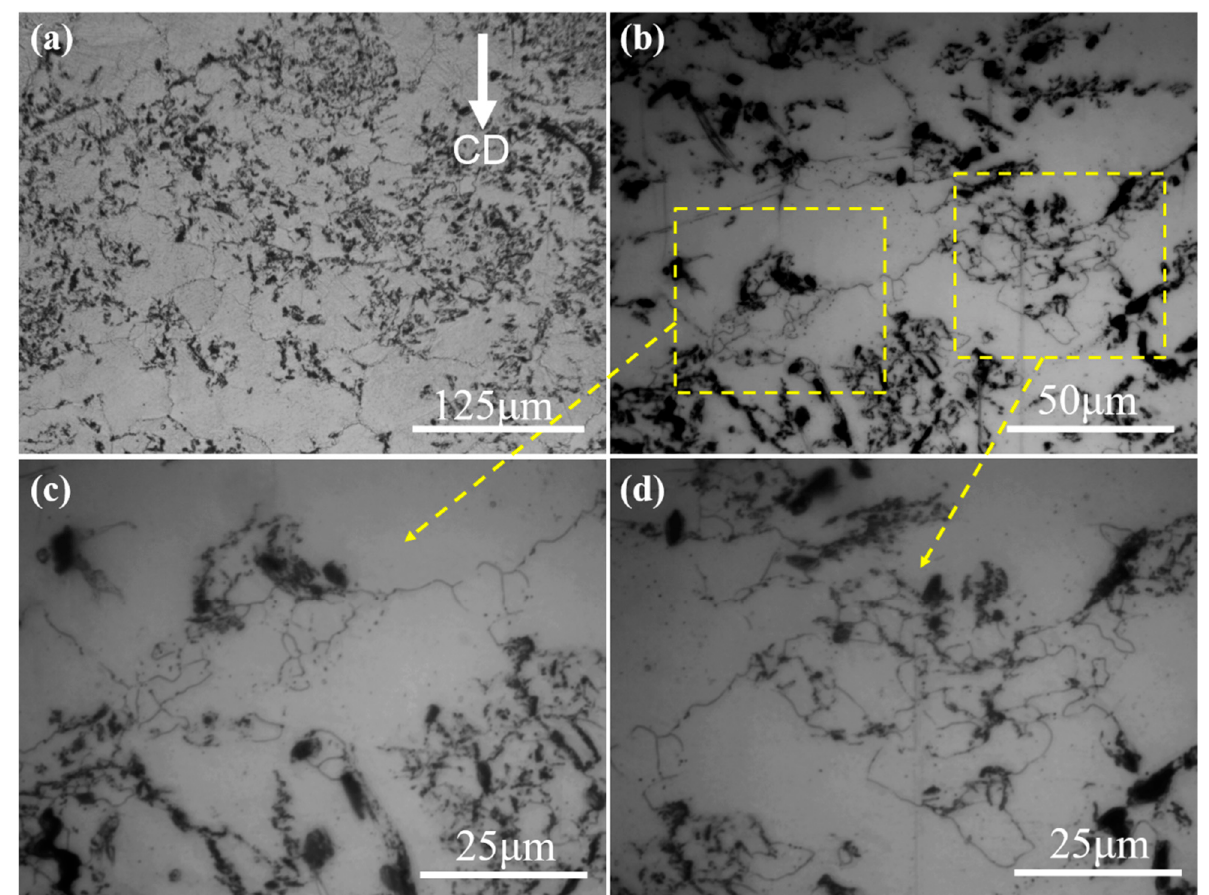
Figure 5. OM microstructure of the SiC p /Mg-5Zn material with a compression strain of 0.05: ( a , b ) low magnification and ( c , d ) high magnification.